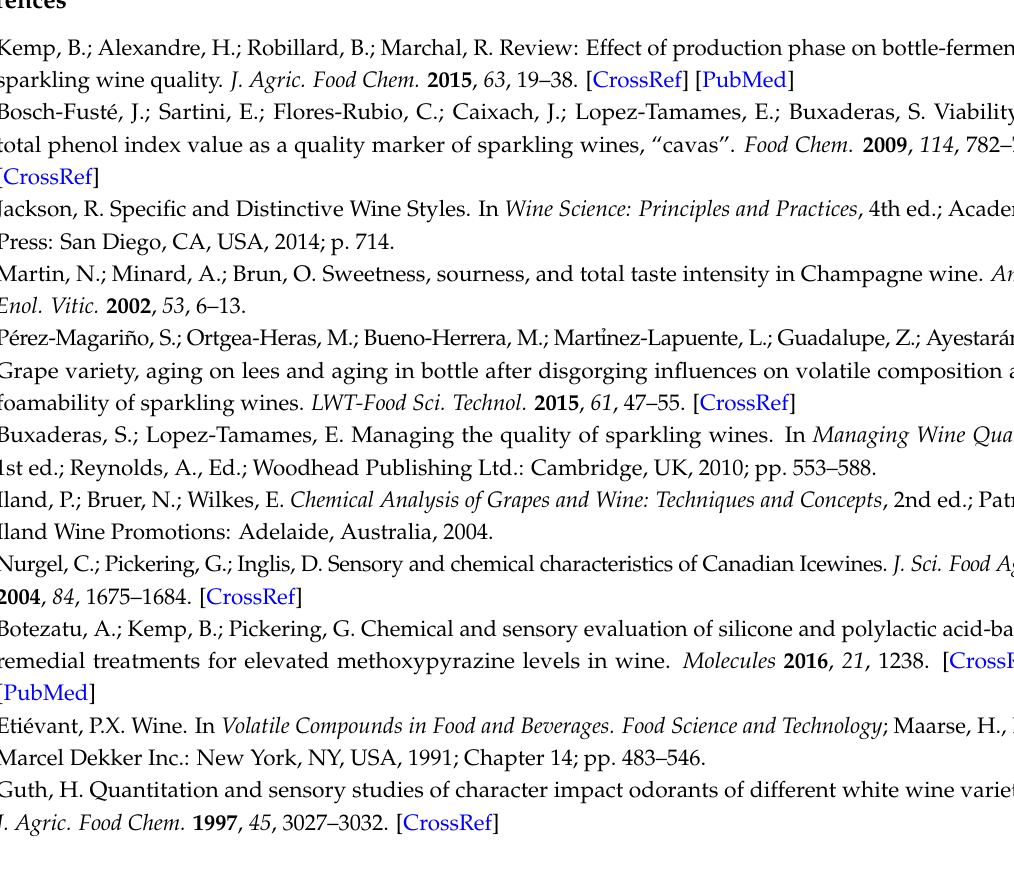
Table S1: Chemical composition of ZD sparkling wines: 5 and 10 weeks post-disgorging, Table S2: Chemical composition of BS sparkling wines: 5 and 10 weeks post-disgorging, Table S3: Chemical composition of OC sparkling wines: 5 and 10 weeks post-disgorging, Table S4: Chemical composition of UC sparkling wines: 5 and 10 weeks post-disgorging, Table S5: Chemical composition of PN sparkling wines: 5 and 10 weeks post-disgorging, Table S6: Chemical composition of IW sparkling wines: 5 and10 weeks post-disgorging, Table S7: Chemical composition of B sparkling wines: 5 and 10 weeks